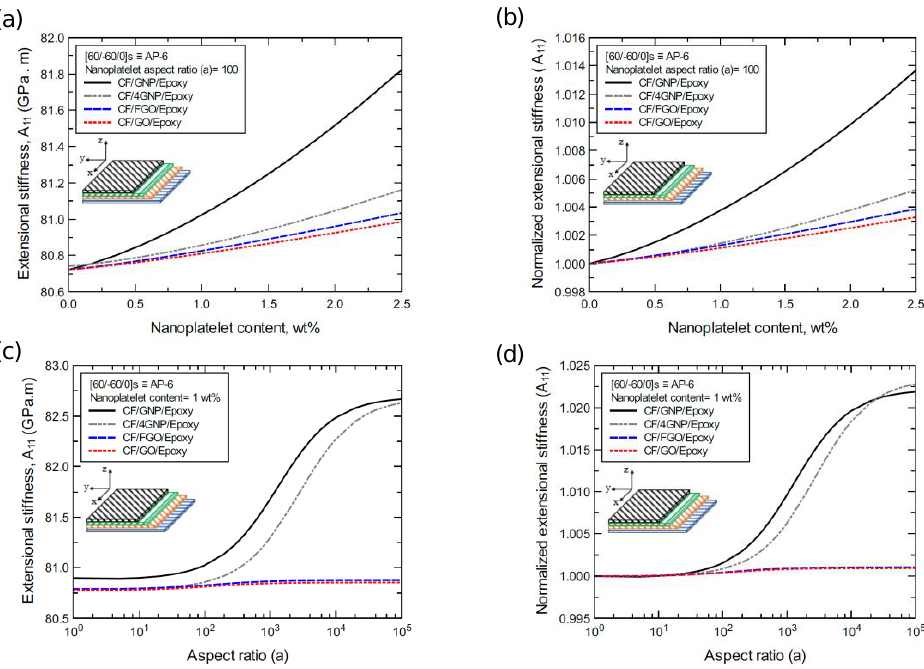
Figure 14. Comparison of the predicted extensional stiffness (A 11 ) for a [60/-60/0]s (AP-6)-laminated composite plate based on the nanoplatelet type, content, and aspect ratio; ( a ) predicted A 11 for various nanoplatelet contents at 100 aspect ratio, and the normalized response is shown in ( b ); ( c ) predicted A 11 for various aspect ratio values at 1.0 wt% nanoplatelet content, and the normalized response is shown in ( d ). The volume fraction of CF is 56%.